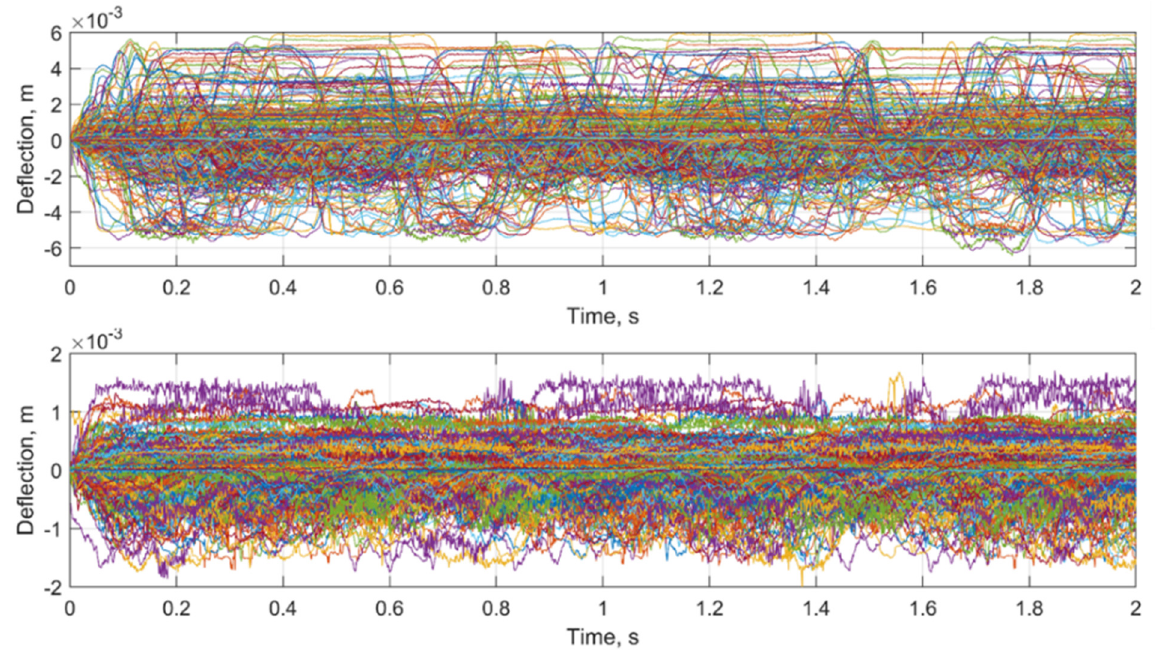
Figure 16. The raw deflection time-series of rail in the void ( top ) and reference zone ( bottom ). The histograms of maximal rail deflection distribution in the voided and reference zone are depicted in Figure 17. The diagrams show that the ballast damage zones are characterized by a wide maximal deflection distribution from about 1.5 mm up to 6 mm. The reference zones have the most measured deflections in a range up to 1 mm but some deflections can reach up to 2 mm. The reason is the influence of the damage-independent factors on the rail deflection such as various subgrade stiffnesses and various superstructure types.